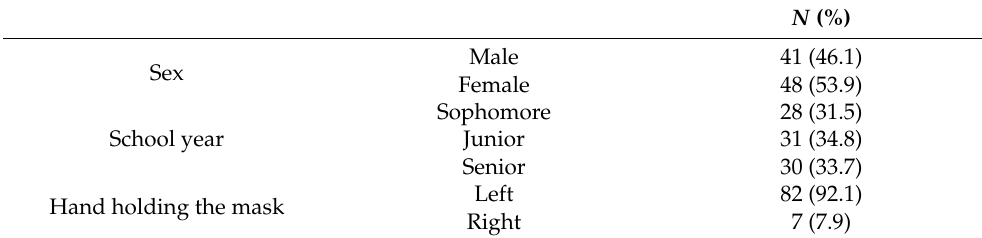
Table 1. General characteristics, N =